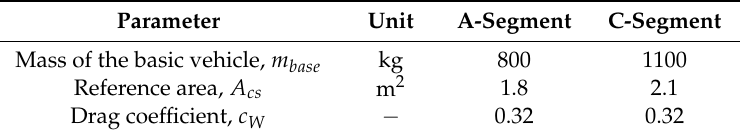
Table 4. Parameters of the A- and C-segment passenger cars investigated. These values are based on the mean values of current A- and C-segment production cars equipped with standard engines